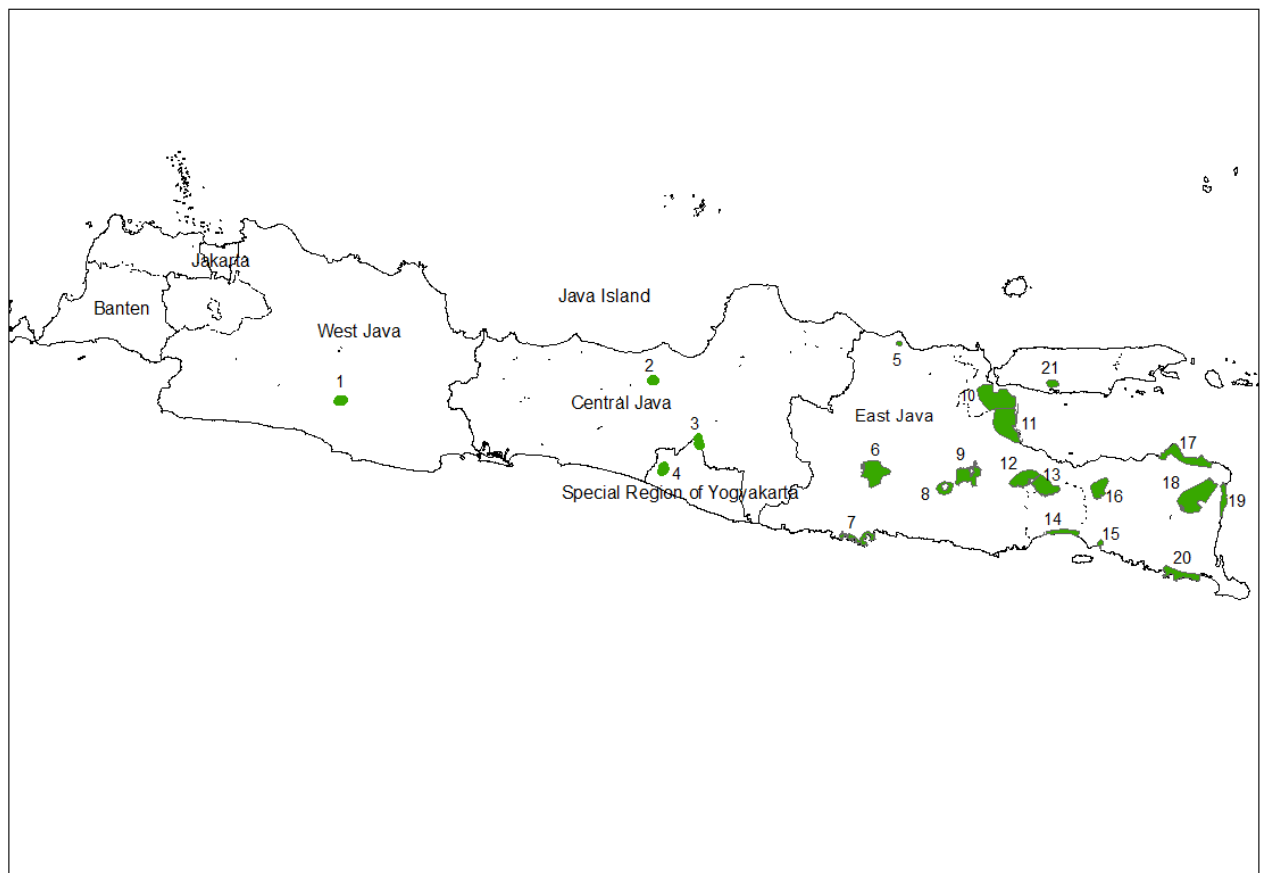
Figure 1. Map of 21 study areas across Java. (1) Cipaganti; (2) Kemuning; (3) Kepuharjo; (4) Jatimulyo; (5) Tuban; (6) Madiun-Kediri (7) Trenggalek; (8) Gunung Kelud; (9) Malang-Batu; (10) Surabaya-Gresik; (11) Sidoarjo; (12) Pasuruan; (13) Probolinggo; (14) Lumajang; (15) Jember; (16) Dataran Tinggi Hyang; (17) Situbondo; (18) Ijen-Baluran; (19) Banyuwangi Utara; (20) Alas-Purwo Merubetiri; (21) Sampang.